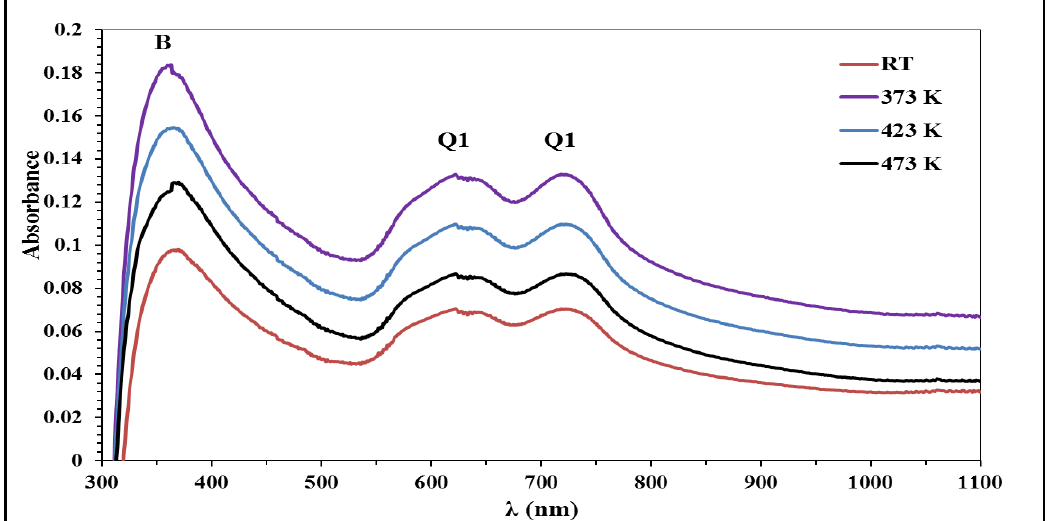
Fig. 5: Absorbance for the blend CuPcTs/PEDOT PSS thin films deposited on glass substrate annealed at different temperature.